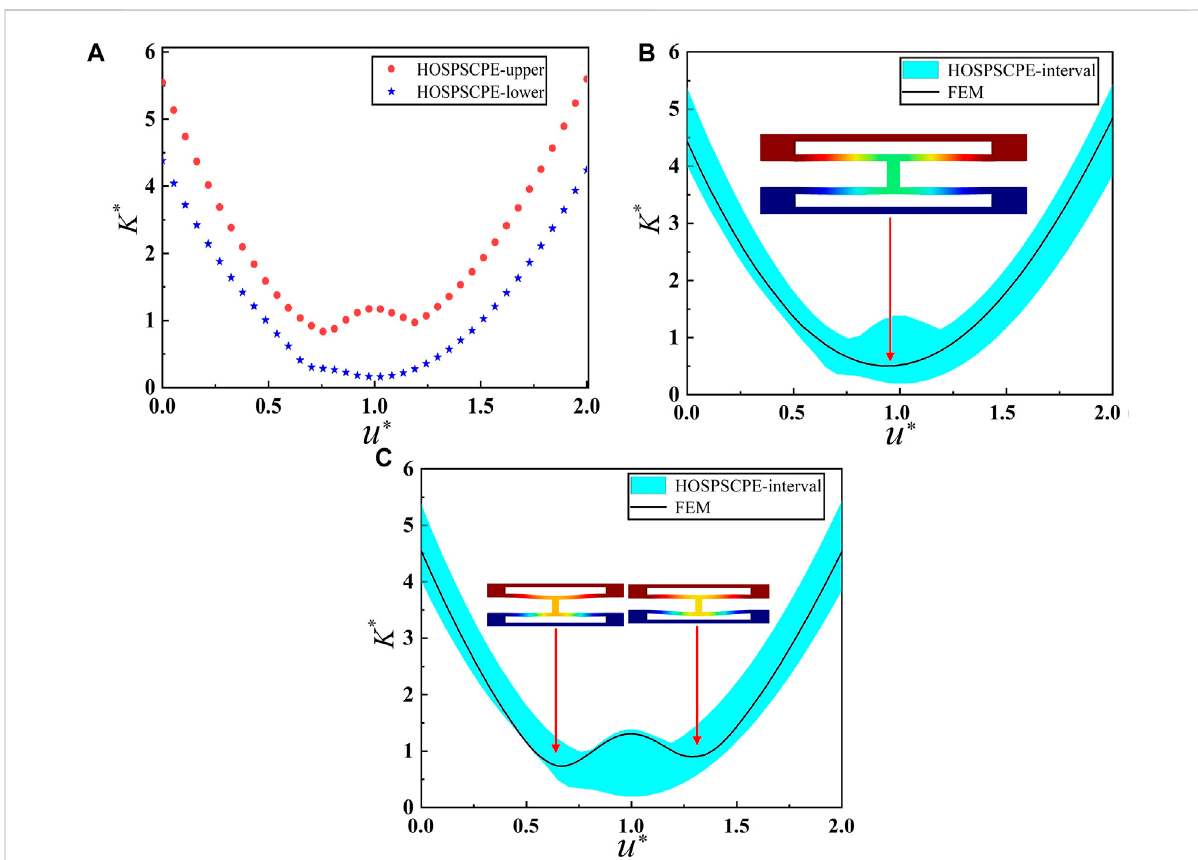
FIGURE 6 Static uncertainty analysis of the QZS unit cell. (A) The stiffness characteristics of the QZS unit cell. (B) Static analysis of the QZS unit cell with symmetrical microstructures. (C) Static analysis of the QZS unit cell with asymmetric